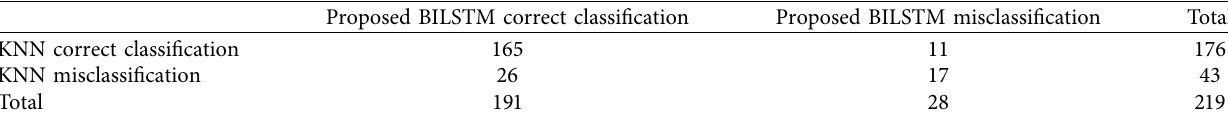
Table 7: J-S emotion class